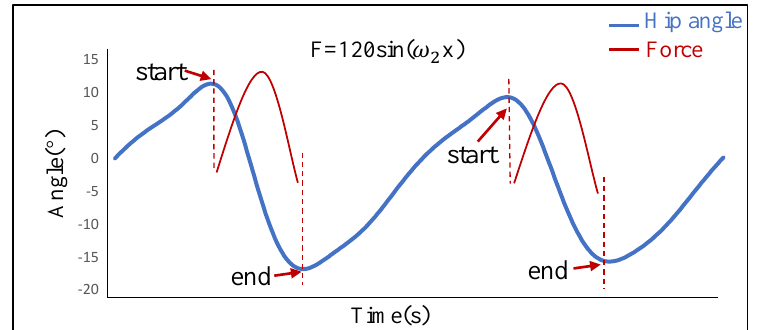
Figure 5. The desired force of the lightweight soft